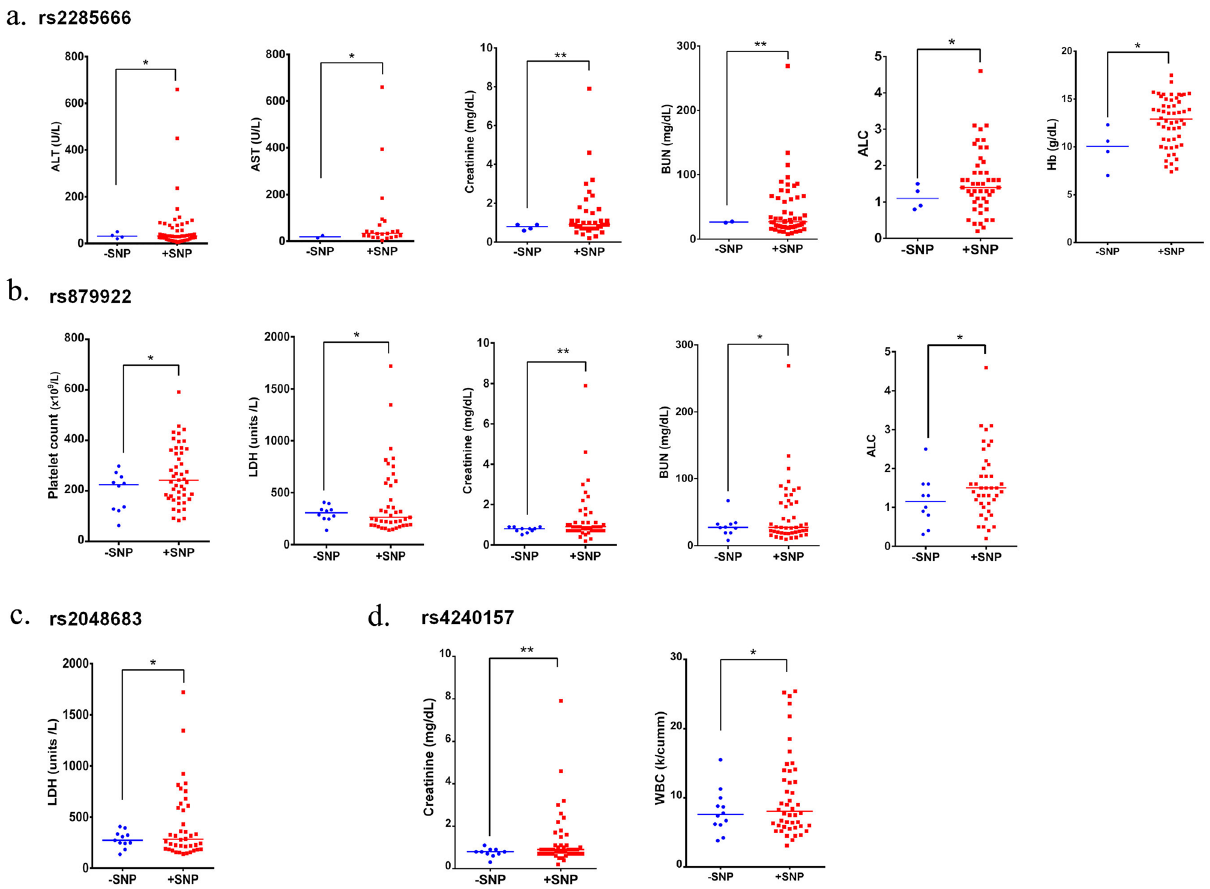
Figure 7. Significant association between rs228566, rs2048683, rs4240157 and rs879922 and elevated levels of blood biomarkers. Significant increase in the levels of ALT, AST, Hb, ALC, creatinine, and BUN clinical tests in COVID-19 patients expressing ( a ) rs2285666. In COVID-19 patients expressing ( b ) rs879922 revealed significant increase in the levels of ALC, creatinine, BUN, and LDH, in addition to platelets count. Increased levels in creatinine, LDH and WBC count in COVID-19 patients with ( c ) rs2048683 and ( d ) rs4240157. * p < 0.05; ** p < 0.01. ALT alanine aminotransferase; AST aspartate aminotransferase; Hb hemoglobin ; ALC absolute lymphocyte count; BUN blood urea nitrogen; LDH lactate dehydrogenase; WBC white blood